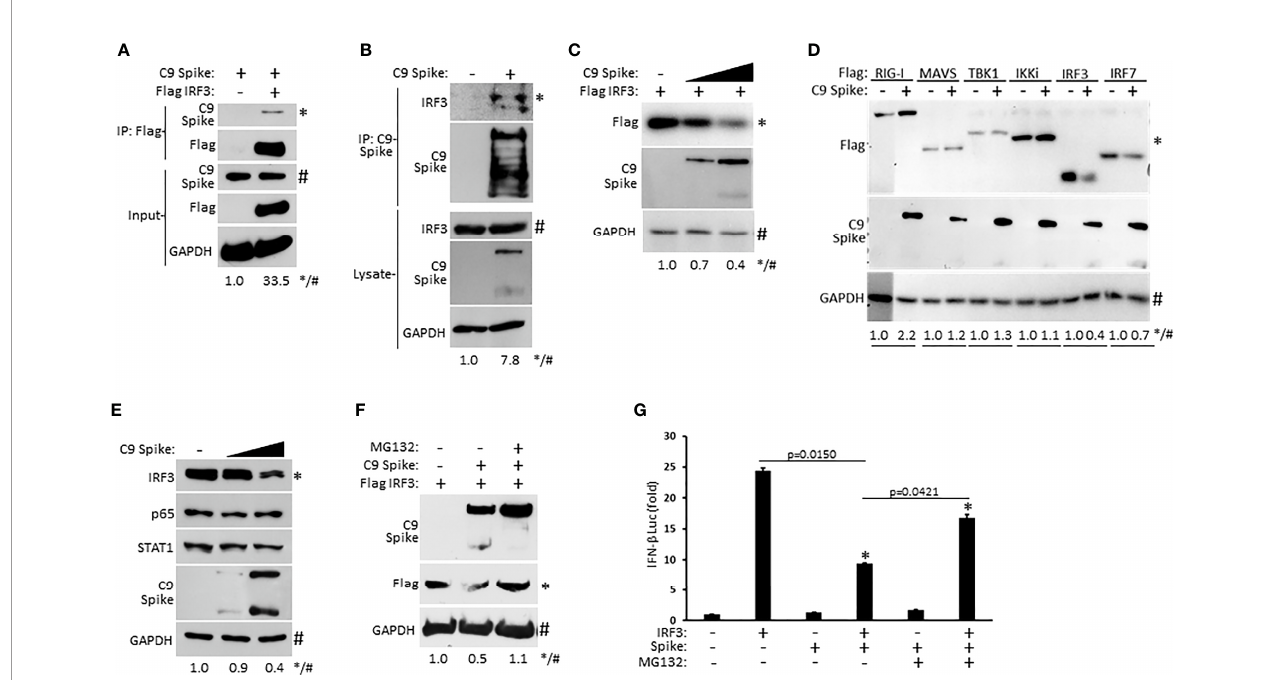
FIGURE 4 | SARS-CoV-2 Spike interacts with IRF3 and mediates its proteasomal degradation. (A) Co-immunoprecipitation and immunoblot of Flag IRF3 (1 µg) with C9 Spike (1 µg) co-transfected in HEK 293T cells. (B) Immunoprecipitation and immunoblot of transfected C9 Spike (1 µg) with IRF3 in HEK 293T cells treated with MG132 (10 µM) for 4h. (C) Immunoblot analysis of Flag IRF3 (250 ng) co-transfected with C9 Spike (500 ng and 1 m g) in HEK293T cells. (D) Immunoblot analysis of Flag RIG-I, Flag MAVS, Flag TBK1, Flag IKKi, Flag IRF3, and Flag IRF7 (1 µg each) co-transfected with C9 Spike (2 µg) in HEK 293T cells. (E) Immunoblot analysis of IRF3, p65, and STAT1 in HEK 293T cells transfected with C9 Spike (500 ng and 1 µg). (F) Immunoblot analysis of Flag IRF3 (1 µg) co-transfected with C9 Spike (2 µg) in HEK 293T cells and subsequently treated with or without MG132 (10 µM). GAPDH serves as a loading control. (G) IFN- b luciferase reporter assays in HEK 293T cells co-transfected with plasmids encoding IRF3 (500 ng) and C9 Spike (1 µg) followed by MG132 (20 µM) treatment for 4 h. *Indicates p < 0.05 as determined by the student ’ s t-test. Results are representative of two independent experiments. The relative band intensity (*/#) of co-immunoprecipitated Flag IRF3 in (A) , co-immunoprecipitated endogenous IRF3 in (B) , Flag IRF3 in (C, F) , Flag RIG-I, Flag MAVS, Flag TBK1, Flag IKKi, Flag IRF3 and Flag IRF7 in (D) and endogenous IRF3 in (E) was measured using ImageJ